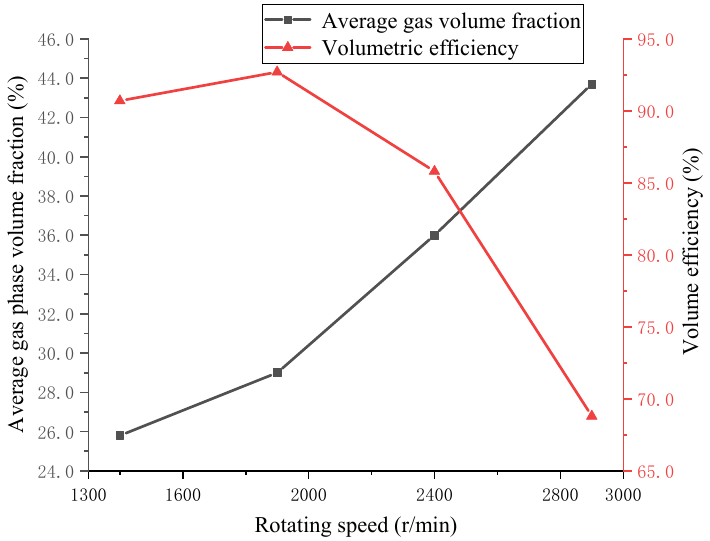
Figure 11. Average gas volume fraction and volumetric efficiency at different rotating speeds.